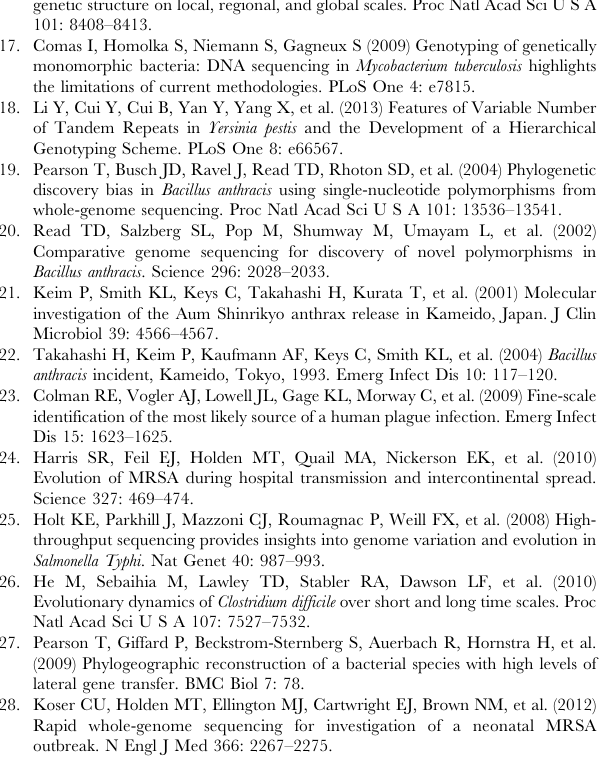
Table S3 List of SNPs used in phylogenetic analysis. Table S4 Primers using in SNPs